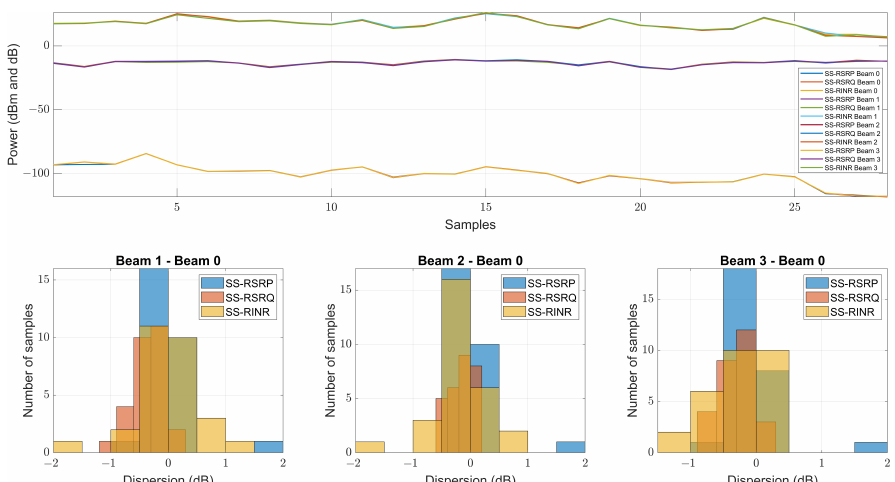
Figure 10. Experimental data of 5G measurements at 868 MHz.